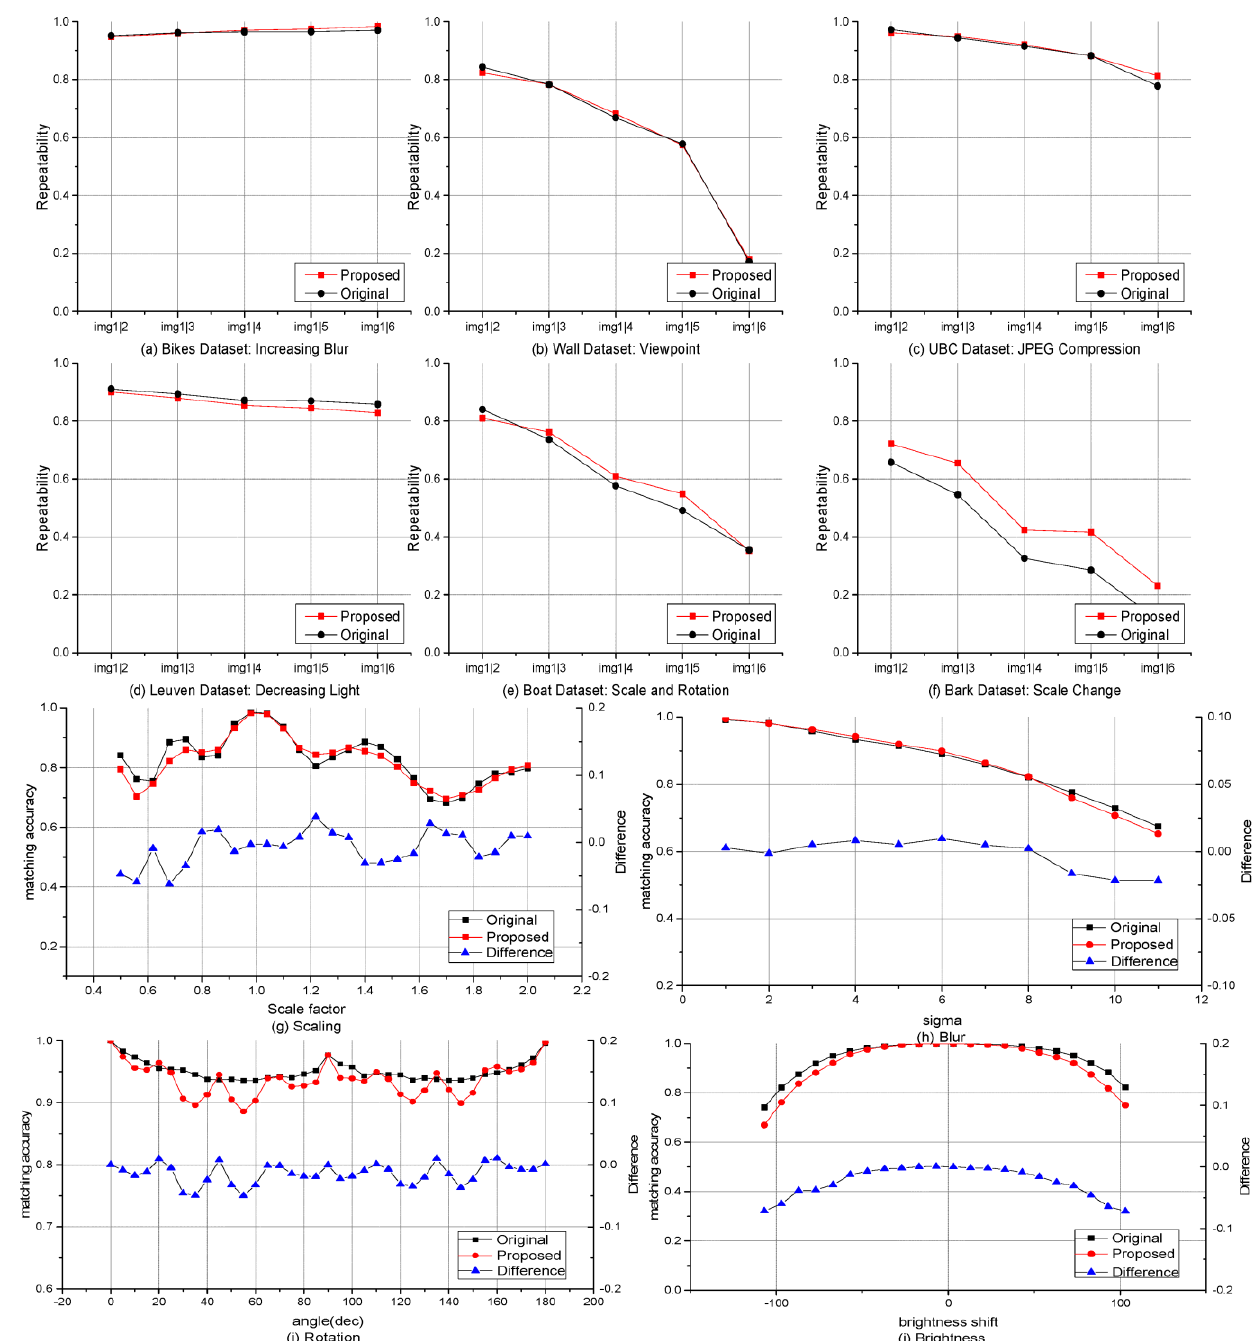
Figure 11. Comparison of detector repeatability ( a – f ) and matching accuracy ( g – j